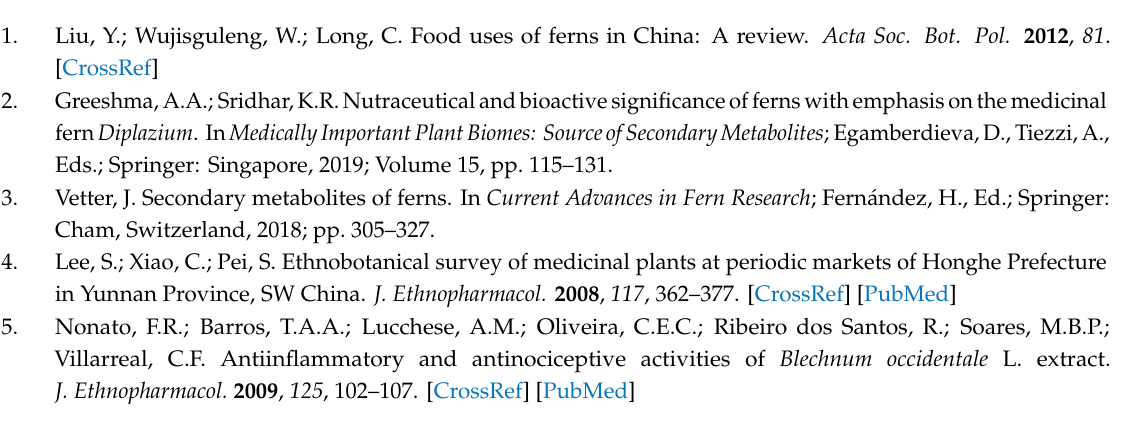
Table S1: E ff ect of di ff erent germination temperatures on SFS (synthetic seeds using fern spores) of bracken, Figure S1: Gametophyte development and response of bracken SFS (synthetic seeds using fern spores) to di ff erent temperature. ap, apical notch; fg, filament gametophyte cell; hg, heart-shaped gametophyte; me, meristematic cell; rh, rhizoid; sc, spore